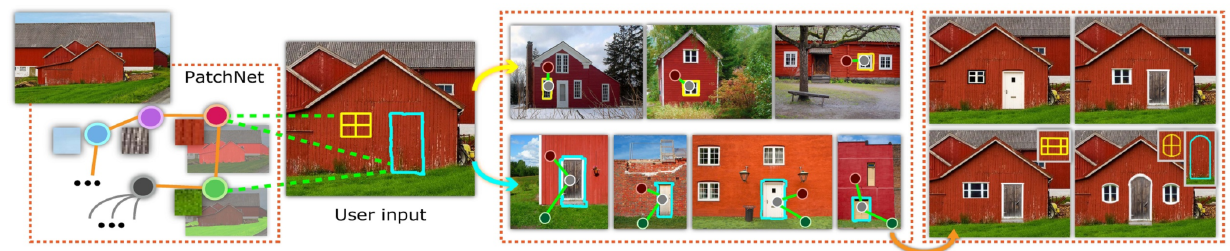
Fig. 9 PatchNet [57] finds a graph that connects local regions, where each local region has an internal repeating texture. PatchNet can be used for library-driven editing applications such as image composition. Reproduced with permission from Ref. [57], c (cid:13) Association for Computing Machinery, Inc. 2013.